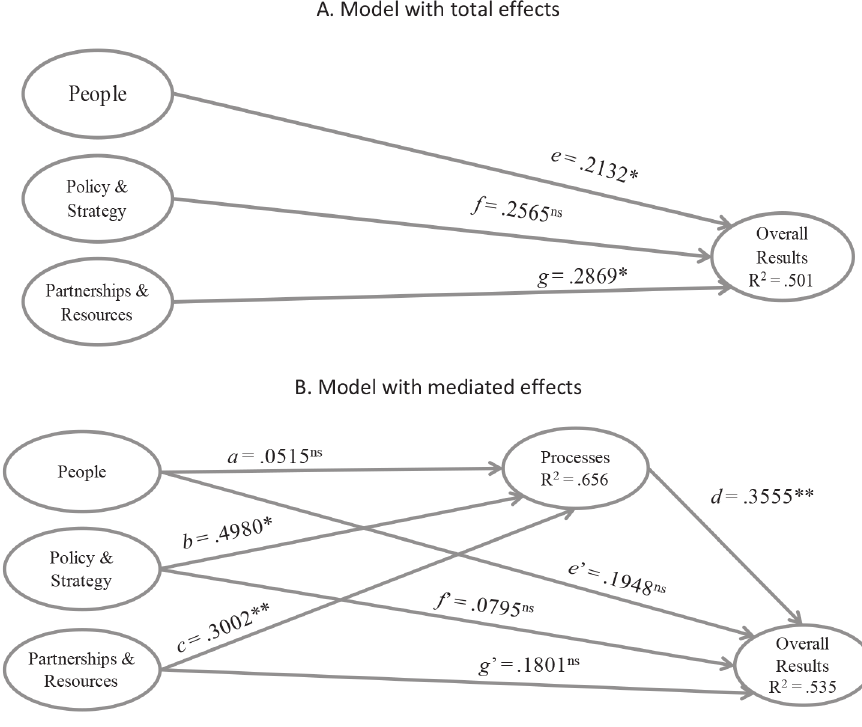
Fig. 2. The mediator role of process